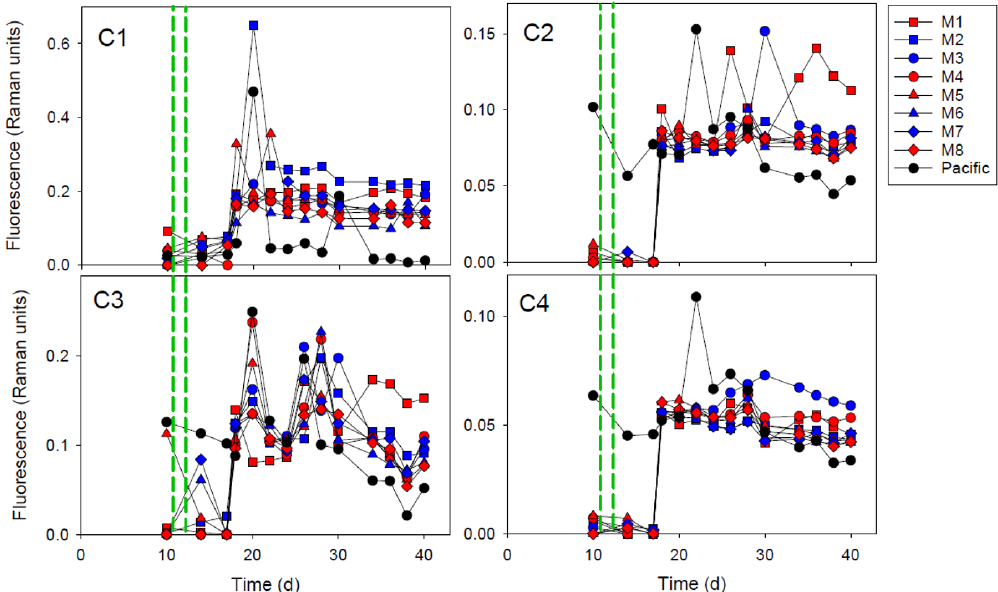
Figure 2. The fluorescent dissolved organic matter (FDOM) components (C1–C4) during the experiment. The red and blue colors denote the mesocosm bags with the addition of water with a low (closer to shore) and very low (further offshore) oxygen minimum zone (OMZ) signature, respectively. The green dashed lines denote the time of OMZ-water addition. Pacific denotes measurements from water collected next to, but outside of, the